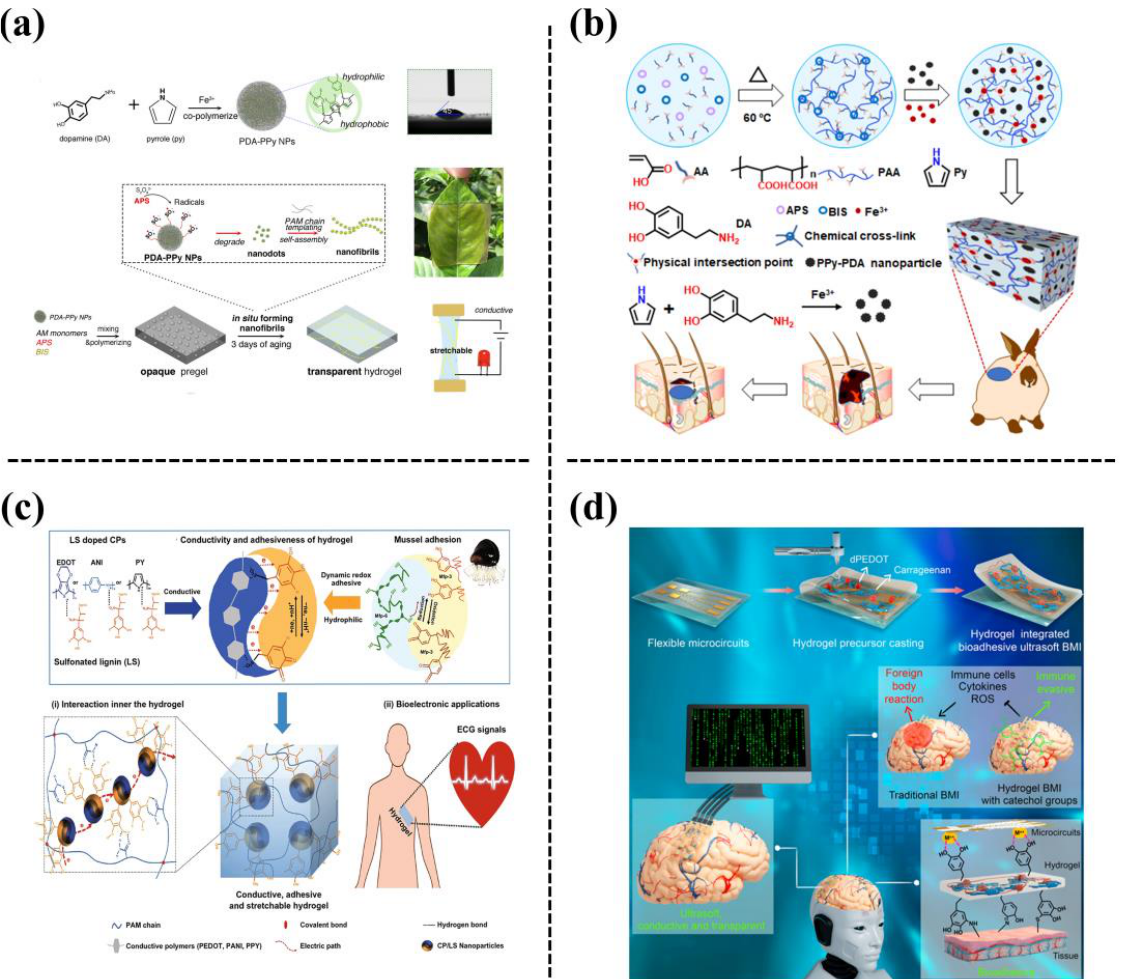
Figure 10. ( a ) A transparent, conductive, stretchable, and adhesive hydrogel was formed by in-situ formation of PDA-PPy nanofibrils in a PAM hydrogel [72]. ( b ) Schematic of the fabrication processes and application of the PPy-PDA/PAA hydrogels [73]. ( c ) Preparation of conductive and adhesive hydrogel based on hydrophilic and redox-active conductive-polymer/sulfonated lignin (CP/LS) NPs [74]. ( d ) A bioadhesive ultra-soft brain-machine interface (BMI) was fabricated based on integration of metallic microcircuits with a dopamine methacrylate-hybridized poly(3,4-ethylenedioxythiophene) nanoparticle (dPEDOT NP)-loaded hydrogel [75].